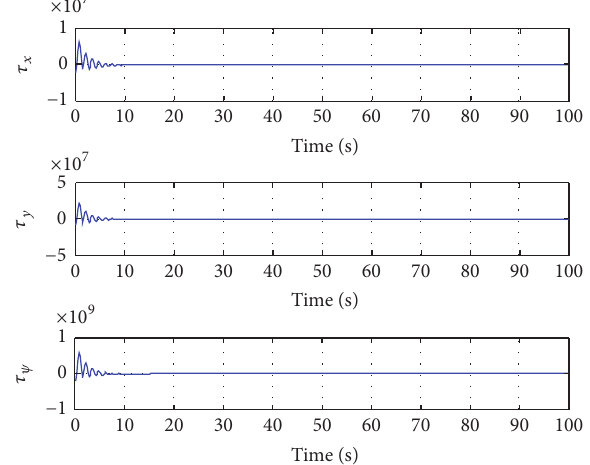
Figure 4: The position error of ship without environmental distur- bances.